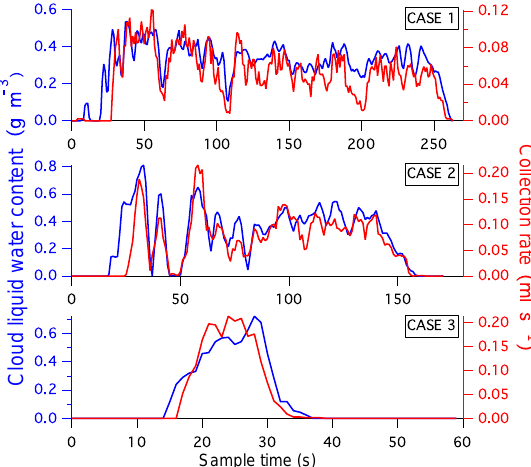
Figure 11. Comparison of instantaneous collection rate (CR) time series with observed cloud liquid water content (LWC) derived from the CDP for the three cases identified in Fig.